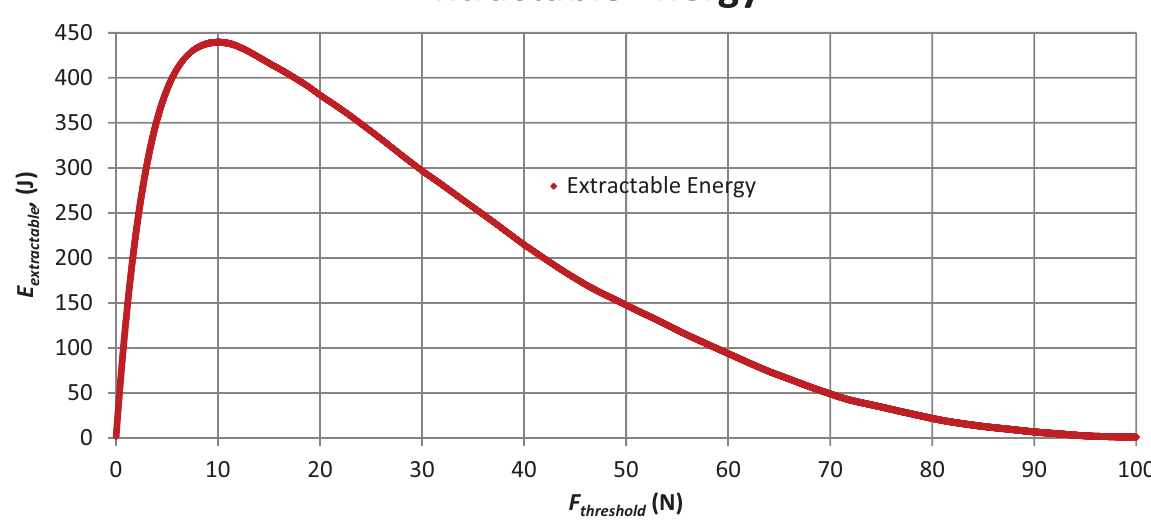
) versus resistance force threshold ( F extractable